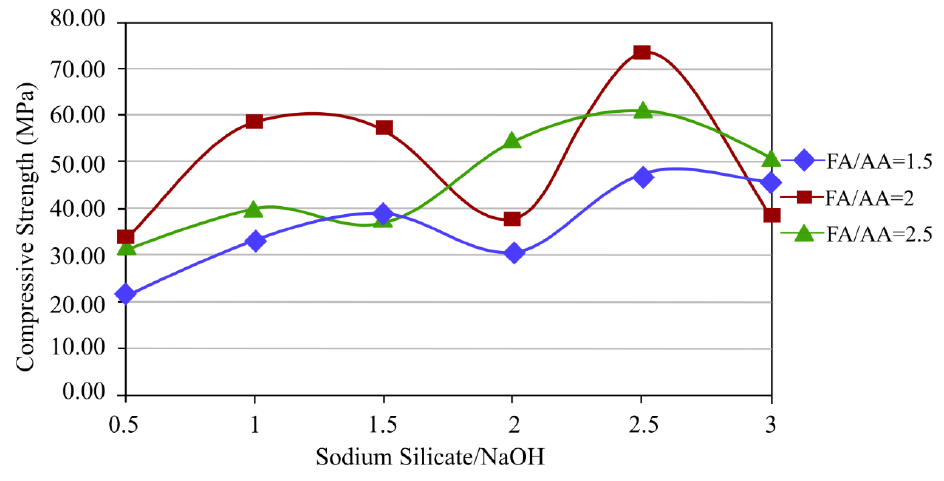
Figure 12. Time versus NaOH solution molarity [144].